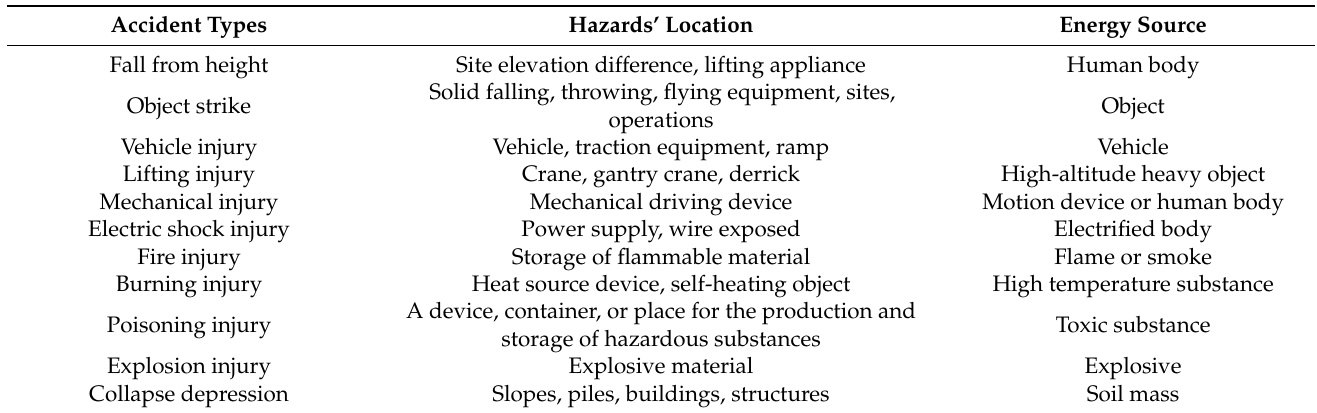
Table 1. Source of